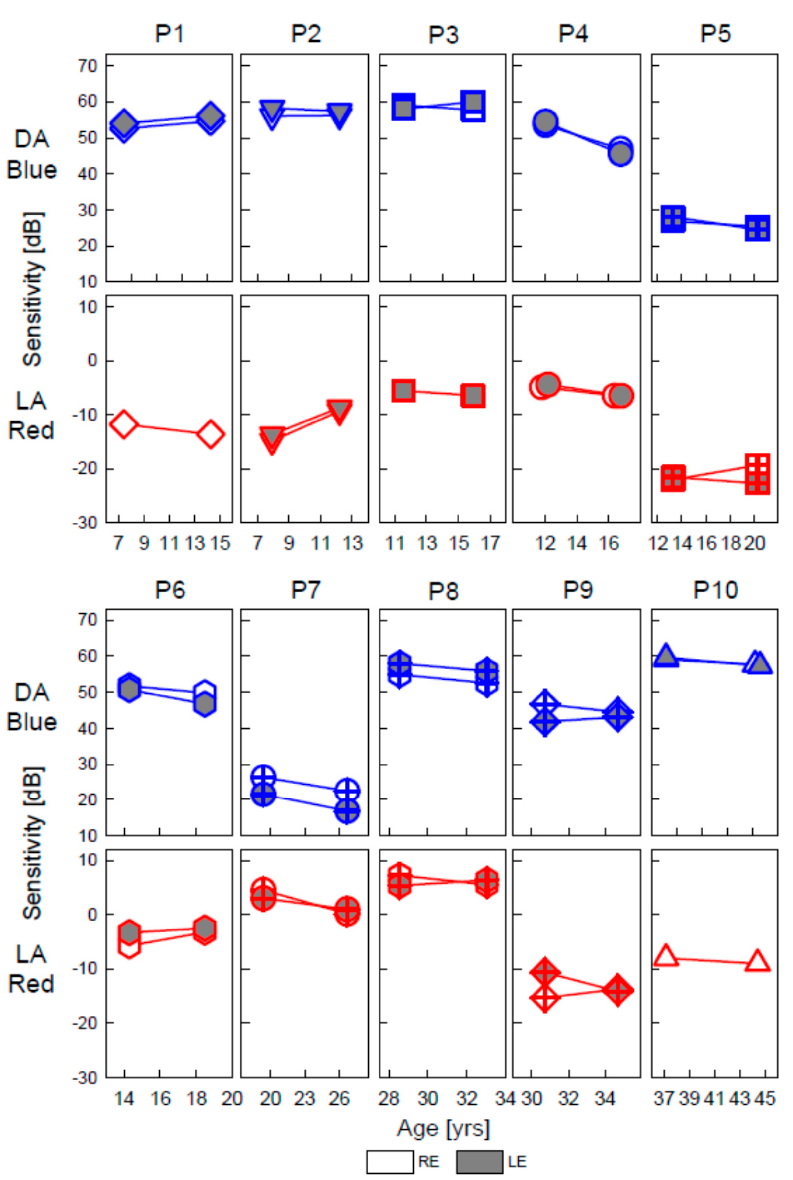
Figure 6. Dark- and light-adapted chromatic full-field stimulus test (FST) results in GUCY2D –LCA patients at two visits. Upper panels: Sensitivity for the blue stimulus in the dark-adapted state, which was detected by rods in all cases. Lower panels: Sensitivity for the red stimulus on a 10 phot cd.m − 2 white background, which was detected by cones in all patients except the RE of P6. Photoreceptor mediation was determined based on chromatic differences: dark-adapted (DA) Blue minus DA Red (not shown); and light-adapted (LA) blue (not shown) minus LA Red. The 0 dB sensitivity level corresponds to − 0.57 log 10 1/(phot cd.m − 2 ).